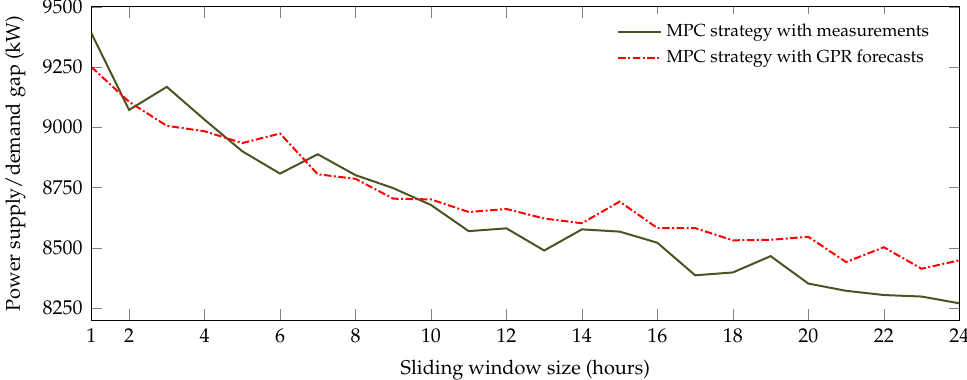
Figure 5. The cumulative power supply/demand gap within the power distribution grid, per sliding window size. The gap before optimisation is 10,035